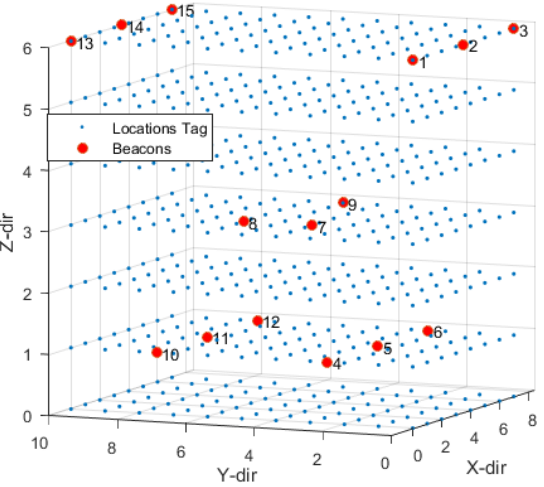
Figure 3. A theoretical 3D space of a 7x10x6 meter cube with a geometry of 15 beacons (red) and possible tag locations